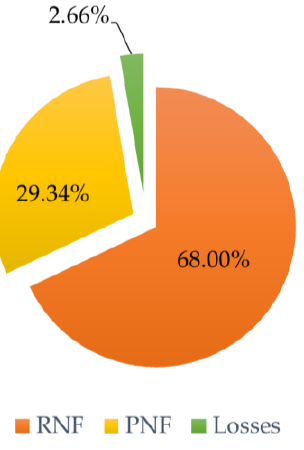
Figure 9. Mass balance of NF process, expressed as percentage on dry yield (%).